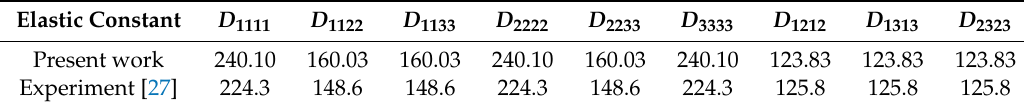
Table 1. Elastic constants D ijkl for single-crystalline Ni 3 Al.